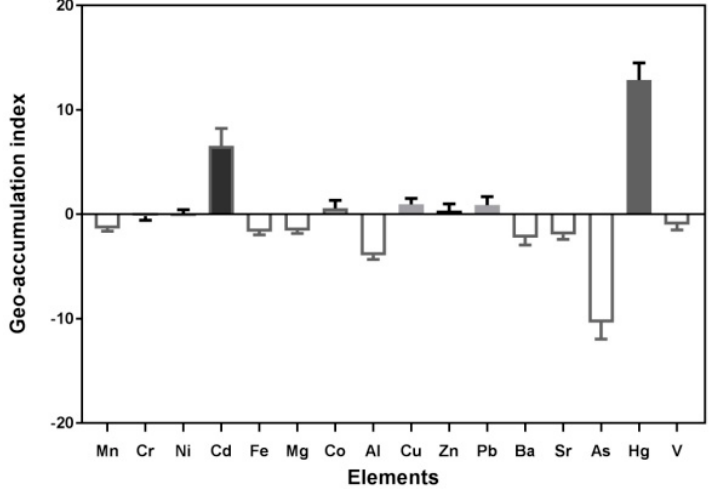
Figure 2. Boxplots of the geo-accumulation index (I geo ) for16 elements in road dust.